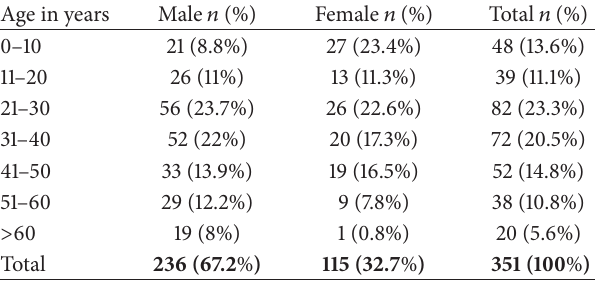
Table 1: Age and sex distribution of the